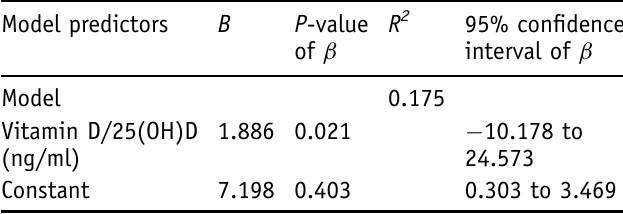
Table III. Multiple linear regression analysis Vitamin D/25 (OH)D predictor for TLR2 expression of Neutrophils in the saliva of SLE.